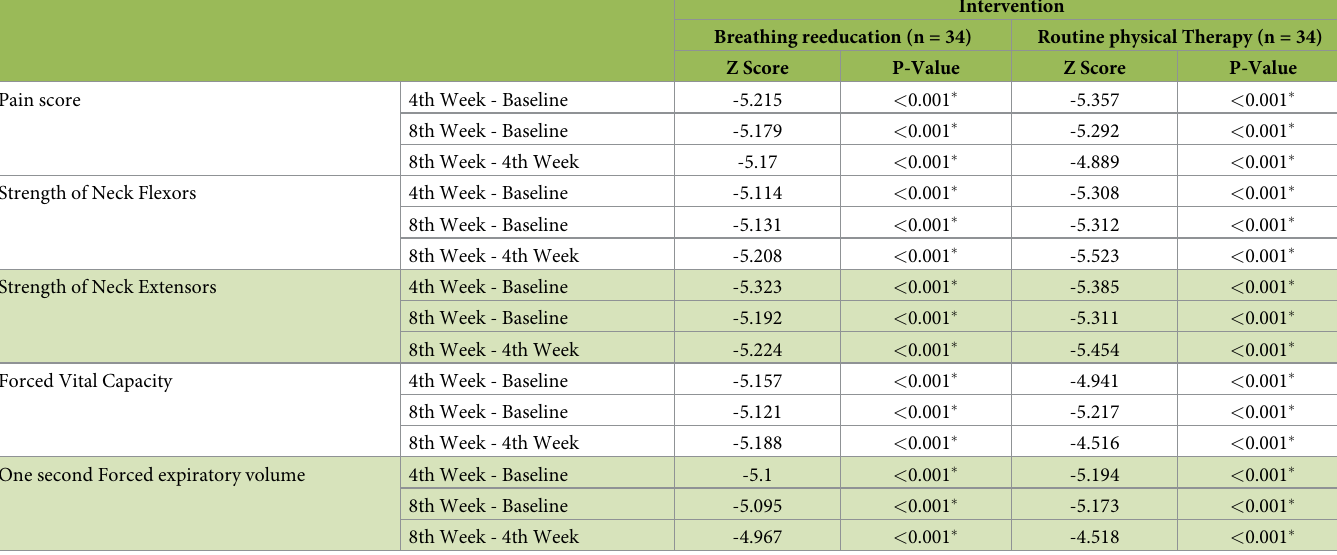
Table 6. Pair wise comparison of pain, strength of cervical flexors and extensors, FVC and FEV1 at baseline, 4 th week and 8 th